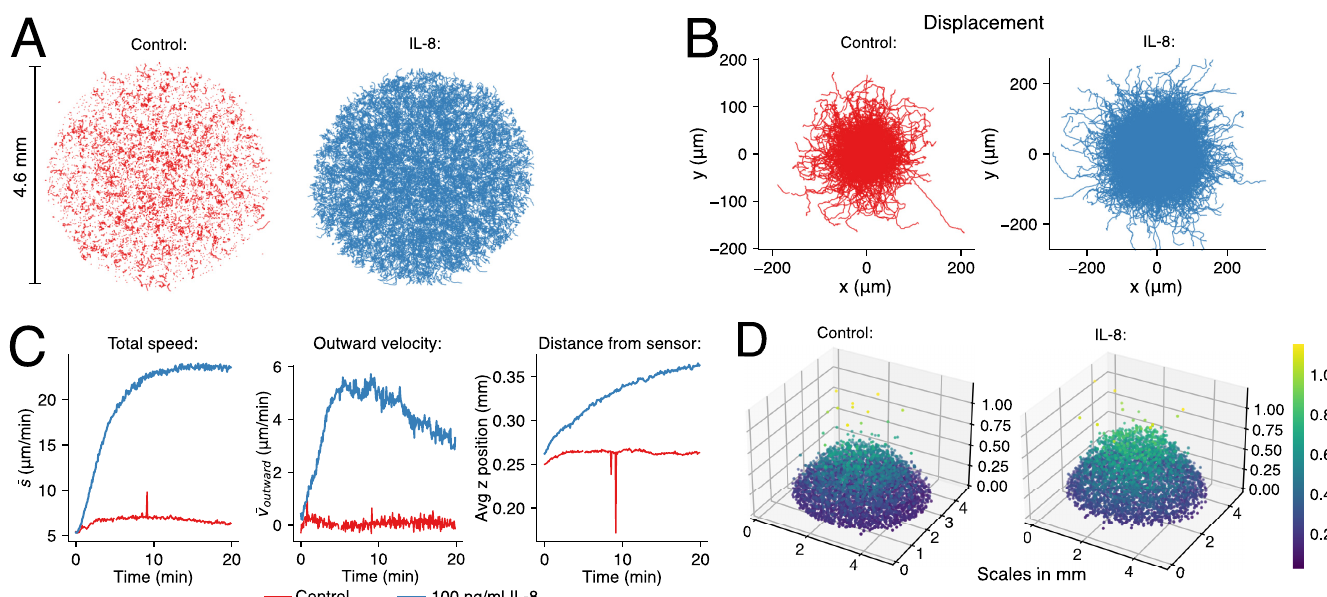
Fig 3. Two example experiments. Neutrophil migration control experiment (red) and with 100 ng/ml in the surrounding medium (blue), about 4000 cells each from the same donor. (A) 2D trajectories (xy-view), recorded over 20 minutes. (B) Rose plot of the same trajectories, each originating at (0,0) (C) Comparison of average speed, average outward velocity and average z-position. The spikes around the 10-minute mark of the control experiment are an artifact as a result of vibrations. (D) Individual cell positions after 20 min without and with 100 ng/ml IL-8 added to the surrounding medium.